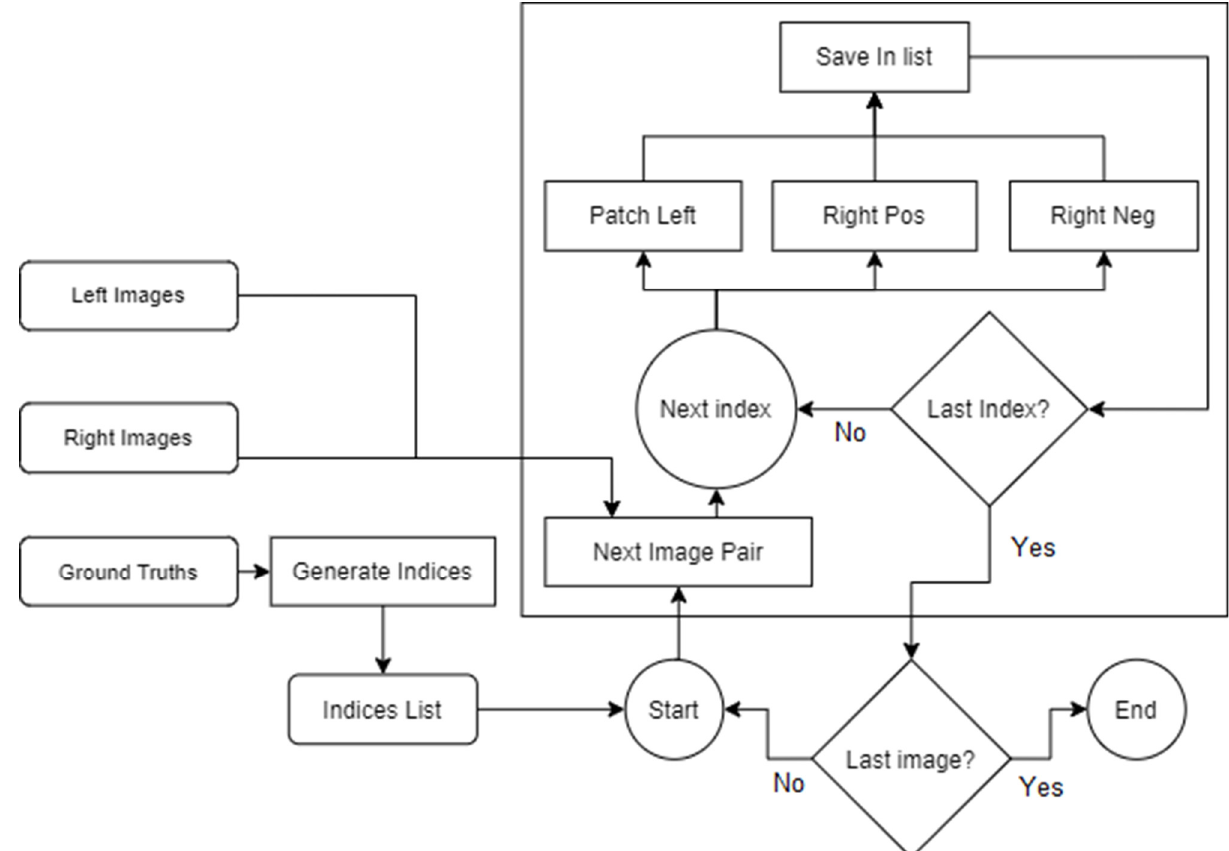
Figure 2. Dataset